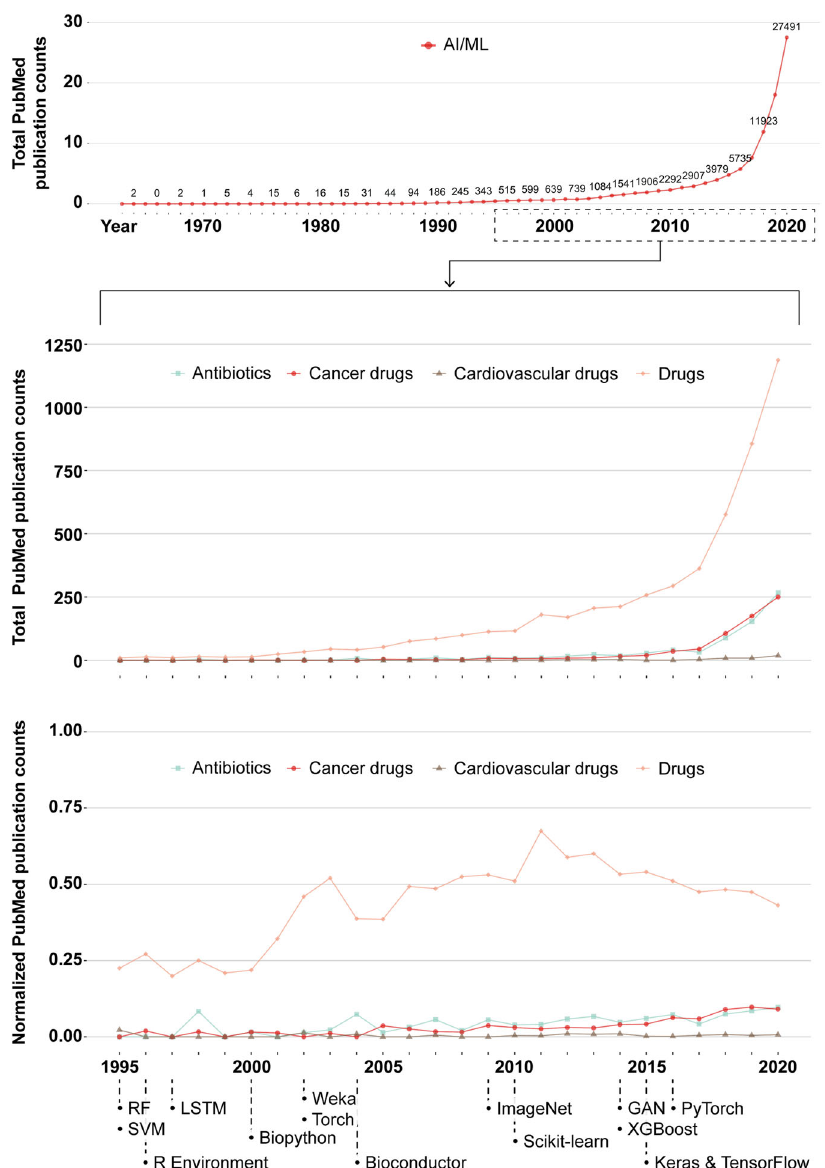
Fig. 3 Machine learning in antibiotic discovery over time. From top to bottom: total PubMed results when querying for AI/ML keywords only, total results when querying for AI/ML and general or disease group-speci fi c drug keywords, and the proportion of general AI/ML publications pertaining to each category of drugs (i.e., total publication counts per drug category scaled by total AI/ML publications per year). Queries sought keywords in titles and abstracts only, with the general drug query excluding keywords contained in the disease group queries to prevent double-counting. Key events in the broader ML community are noted to contextualize trend lines. The relevant literature used to set key dates are as follows: development of SVM 146 and random forest algorithms 147 in 1995; publication of the R language and software environment in 1996 148 ; development of LSTM in 1997 149 ; development of the Biopython package in 2000 150 ; release of the Java interface for Weka in 2002 151 ; publication of the Torch library in 2002 152 ; release of Bioconductor in 2004 153 ; the publication of ImageNet in 2009 154 ; the initial release of Scikit-learn in 2010 155 ; the initial release of XGBoost 156 and development of GANs 102 in 2014; development of Keras 157 and TensorFlow 158 in 2015; and the initial release of PyTorch in 2016 159 . Exact Boolean searches in PubMed can be found in Supplementary Table